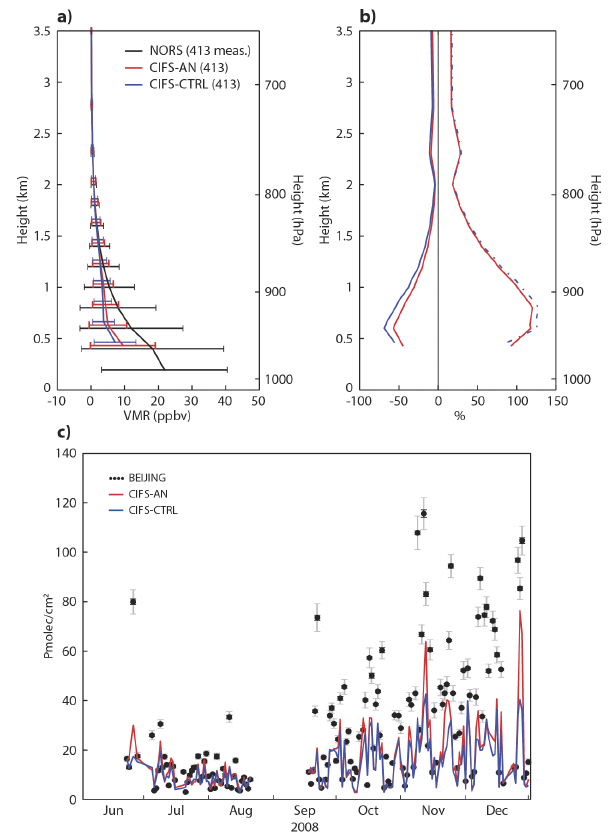
Figure 23. (a) Mean NO 2 profiles in ppbv from UVVIS DOAS in- strument at Beijing (black), CIFS-AN (red) and CIFS-CTRL (blue); (b) mean bias (solid line) and SD (dotted lines) profiles in % for the period 1 June–31 December 2008; and (c) time series of daily mean partial NO 2 column for the layer between 0.3 and 3.5km in 10 15 moleculescm − 2 . A total of 413 measurements were available during the